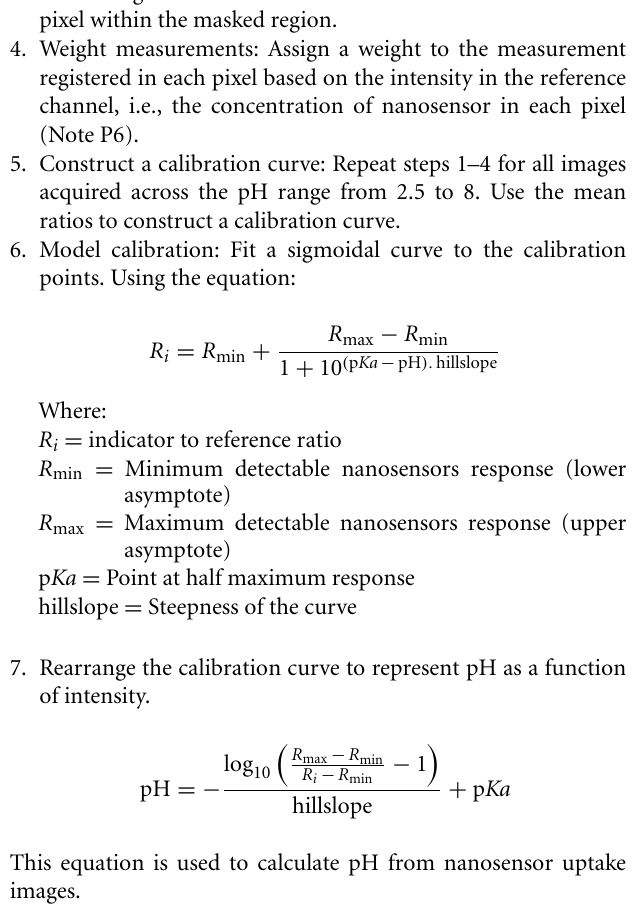
Table 4 | Volumes of sodium phosphate dibasic 0.2M and citric acid monohydrate 0.1M required to make pH buffer solutions from pH 2.5 and